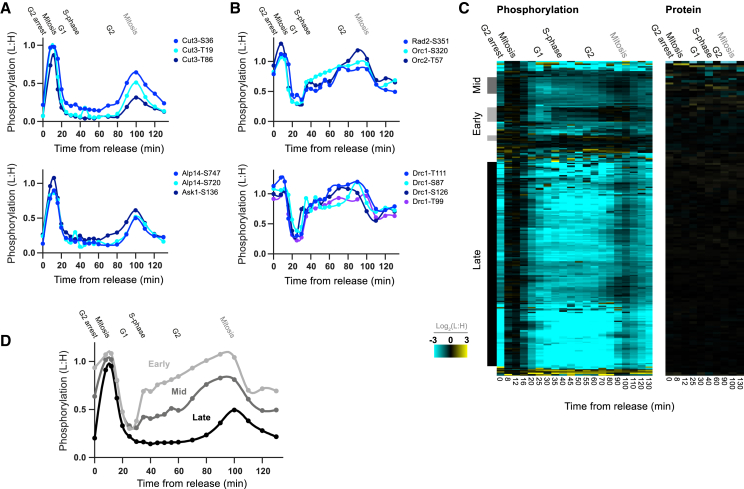
CDK Substrate Phosphorylation Dynamics during the Cell Cycle(A and B) The relative phosphorylation of individual CDK substrate sites after release from G2 arrest for mitotic (A) and S-phase (B) related proteins. Spline connects points.(C) Heatmap of CDK substrate site phosphorylation (n = 256) and protein (n = 149) levels after release from G2 arrest. Each row corresponds to a single phosphosite or protein, respectively. Rows are ordered according to hierarchical clustering, after imputation to replace missing values. Clusters of early (light gray, n = 16), mid (dark gray, n = 12), and late (black, n = 169) substrate sites are annotated. Values outside the display range are set to the closest extreme.(D) The median relative phosphorylation of early, mid, and late CDK substrate sites after release from G2 arrest. Spline connects points.See also Figure S2. See Figure S2A for experimental design.